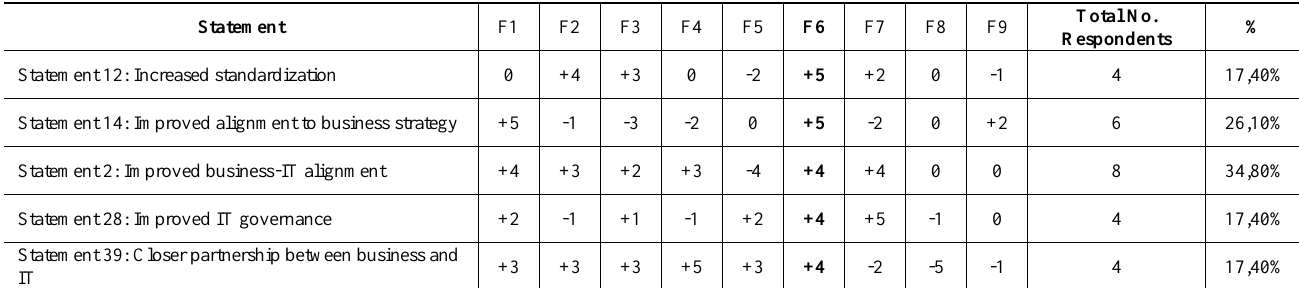
Table 10: Factor 6. IT commoditiser, key